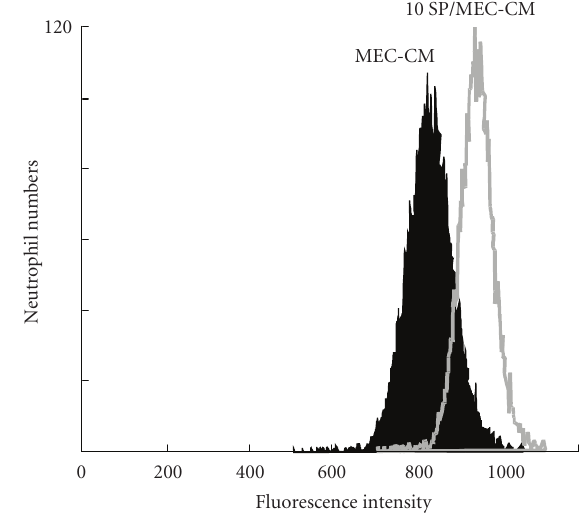
Figure 3: Flow cytometric analysis of the expression of CD11b/ CD18 on neutrophils. The expression of CD11b/CD18 on neu- trophils was significantly higher in the 10SP/MEC-CM than in the MEC-CM ( P < . 05).